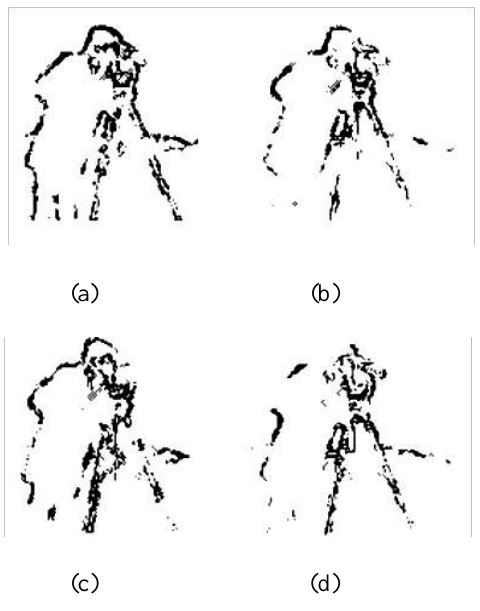
Figure 5. The results of edge detection with ACO algorithm in reference [1]. (a-d) the proposed ACO based image edge detection algorithm with the incorporation of the function defined in